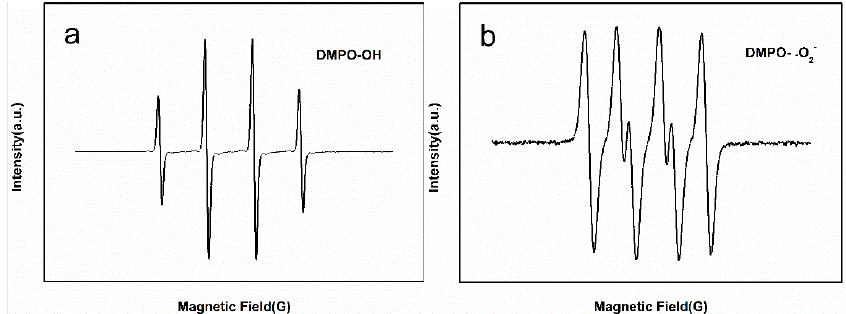
Figure 9. EPR spectra of: ( a ) DMPO-OH adducts and ( b ) DMPO-O 2 − adducts.